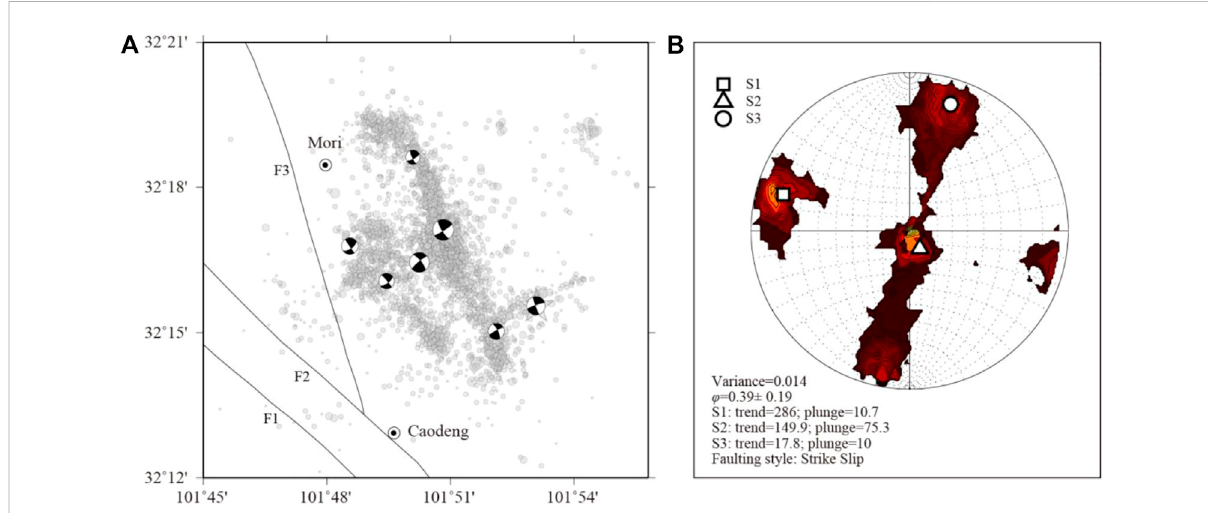
FIGURE 13 (A) Focal mechanisms for the events that were analyzed in this study. (B) Stress fi eld that was inverted via the SSI method using the focal mechanisms in (A) . The other symbols in (A) are the same as those in Figure 3. S1, S2, and S3 are the principal stresses, ordered from most compressional to most dilatational, and contours indicate the uncertainty range of each axis at the 95% con fi dence interval and the variance and φ representing the solution mis fi t and relative stress size, respectively [see Michael (1991) for further details of the SSI